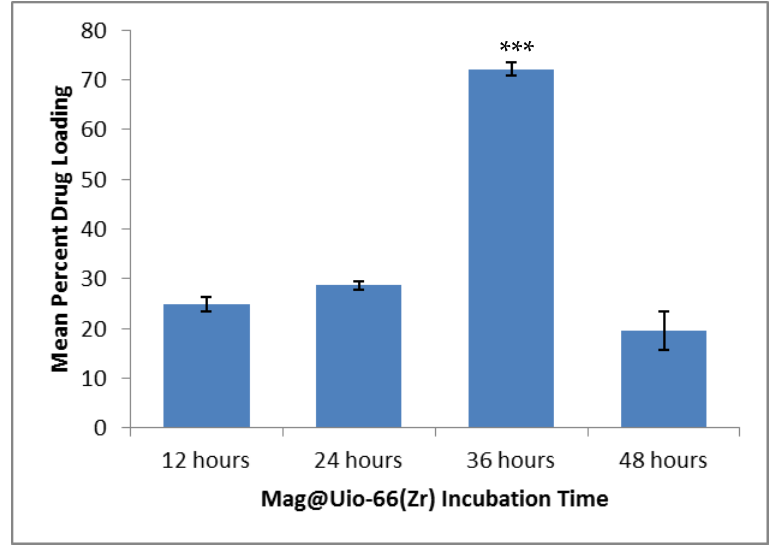
Figure 2. Mean drug loading efficiency of magnolol at four different time points. n = 3. Data presented as mean ± S.E.M.; *** significant difference at 0.05 p -value